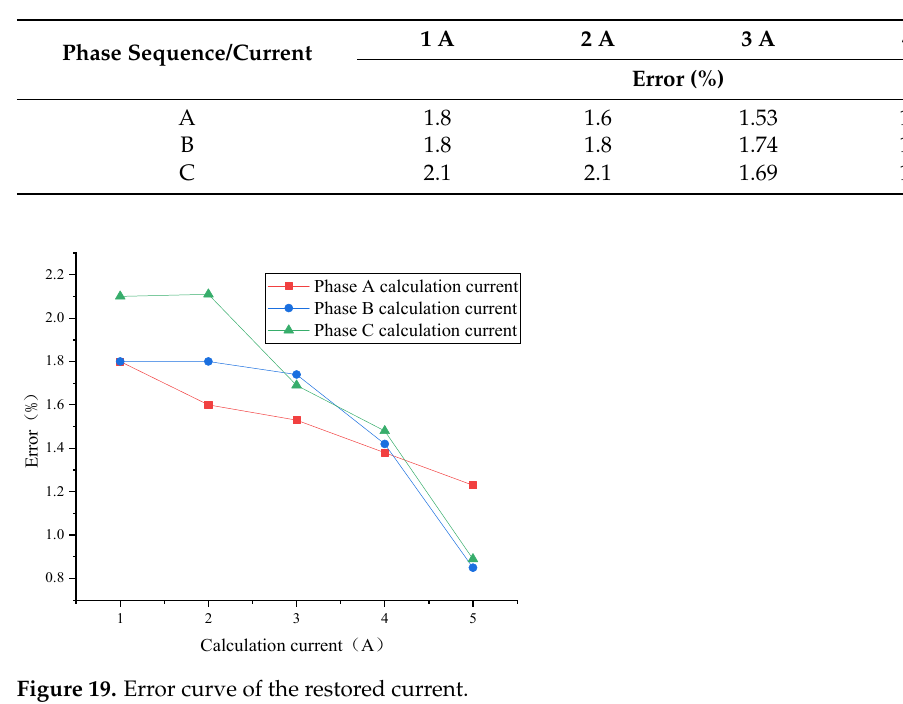
Figure 18. Di ff erent current reduction waveforms. ( a ) Restore waveform when current is 3 A; ( b ) Figure 18. Different current reduction waveforms. ( a ) Restore waveform when current is 3 A; restore waveform when current is 2 A. ( b ) restore waveform when current is 2 A. Table 4. The error between the reduction current and the theoretical current. Table 4. The error between the reduction current and the theoretical current.